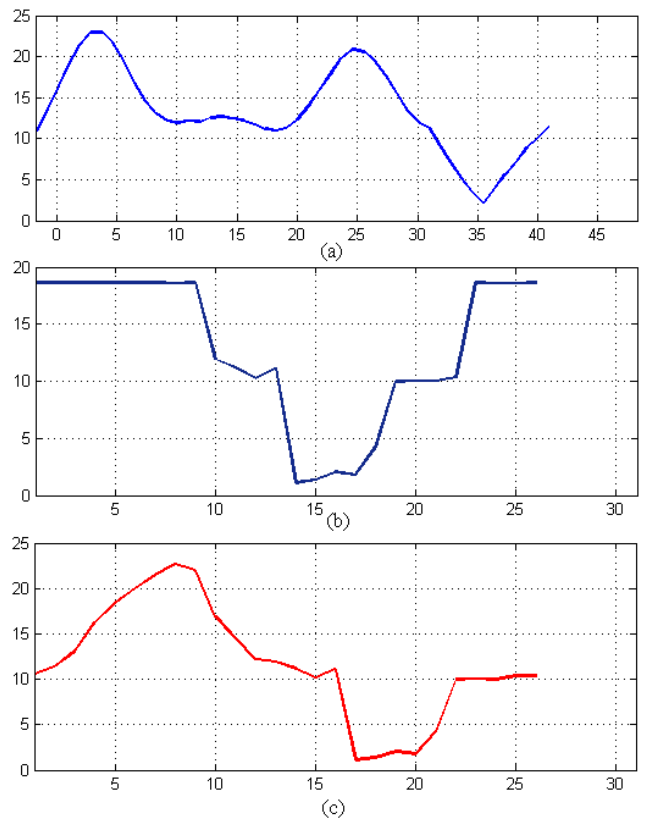
Figure 7. Pseudo pressure values in ‘bar’ on the y-axis for ( a ) consumption pattern (CP) (per hour on the x-axis), ( b ) tap event (TE) (per second on the x-axis) and ( c ) seepage event (SE) (per second on the